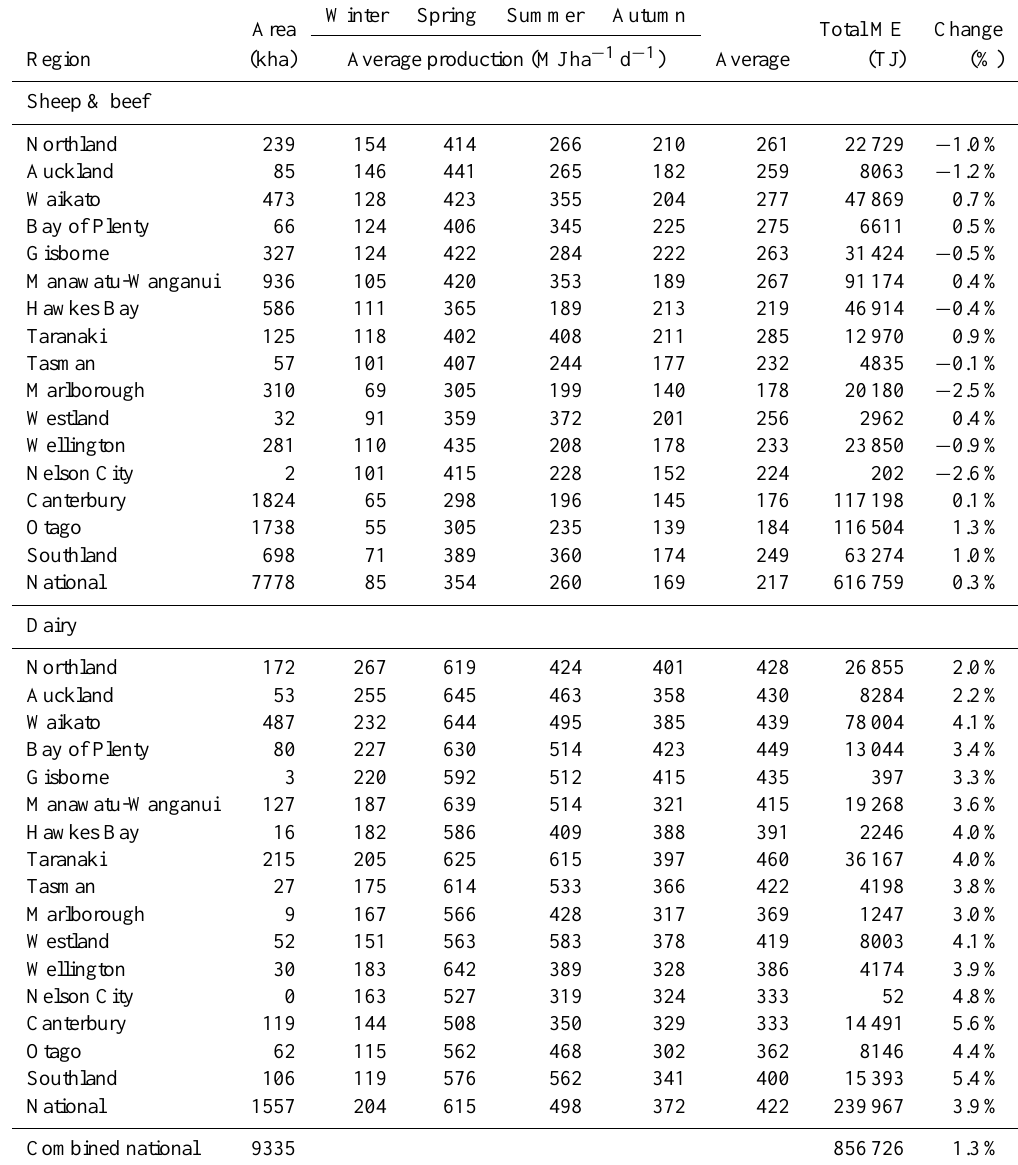
Table B6. Climate change 2050 (MPI